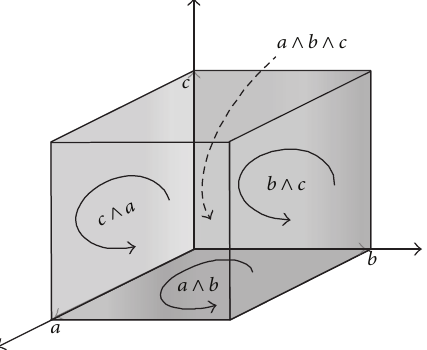
Figure 1: Representation of geometric objects: vector, bivector, and trivector.